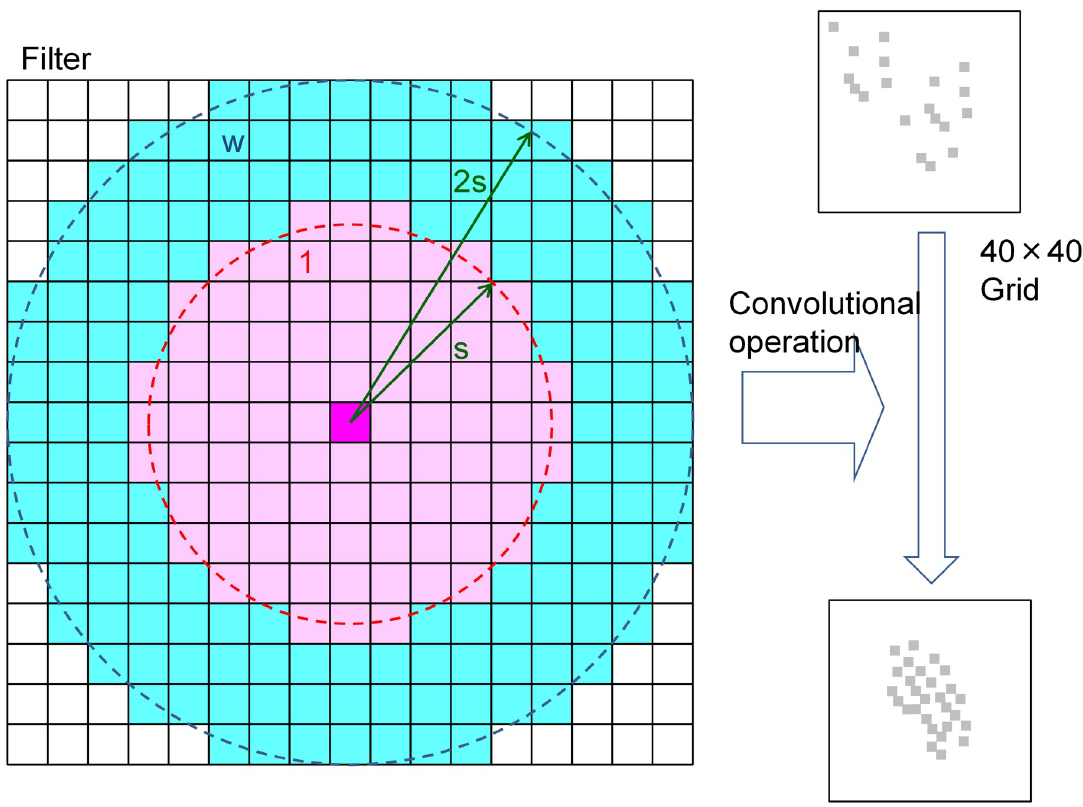
Fig 4. Overview of convolution operation by the